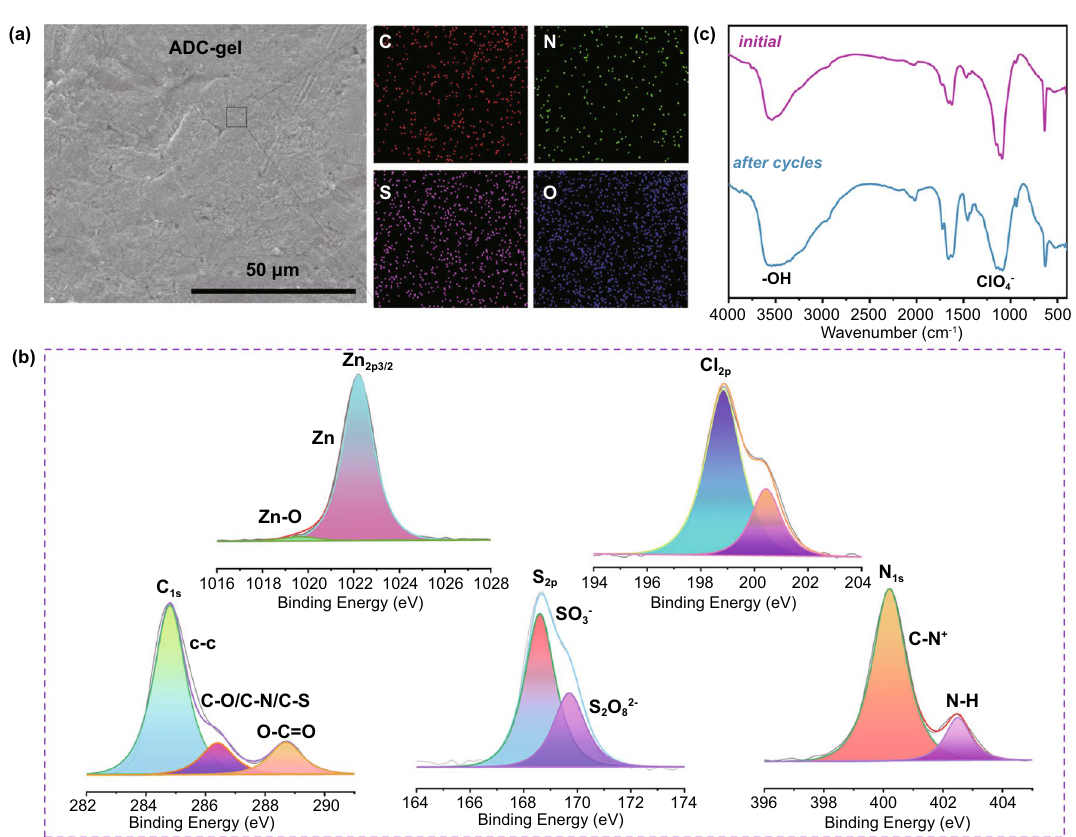
Fig. 4 a SEM image of the Zn anode in ADC-gel after 60 cycles and the corresponding EDS images of the C, N, S, O elements. b High-resolu- tion XPS spectra of the surface of the cycled Zn anode. c FTIR spectra of the initial state of the ADC-gel and the surface layer of the zinc anode after cycled in the gel